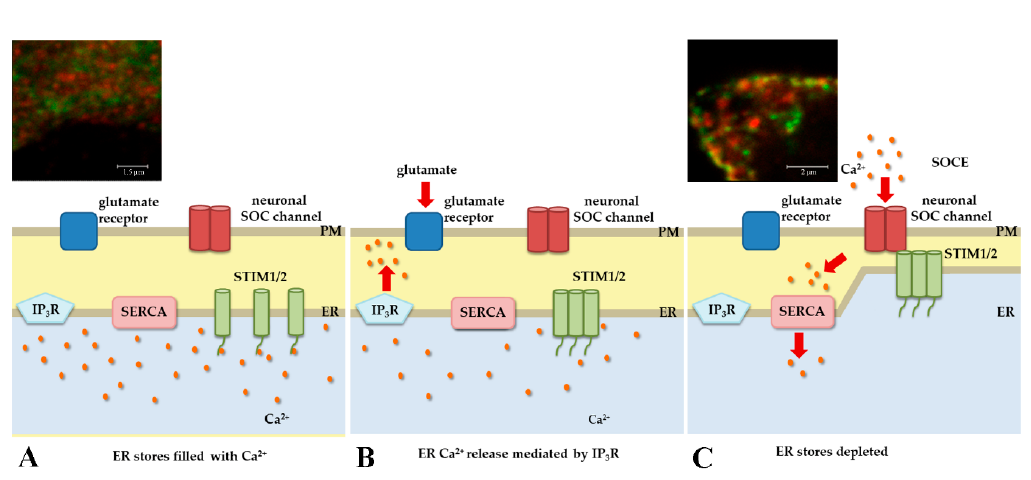
Figure 2. Model of coupling between STIM1 / 2 proteins and Orai channels during SOCE. ( A ) In the absence of external stimuli, STIM1 / 2 proteins are equally distributed throughout ER membrane and ER Ca 2 + concentration is high. ( B ) After glutamate activation, IP 3 R depletes ER Ca 2 + stores. Ca 2 + dissociates from STIM1 / 2 N-terminal domain which results in STIM1 / 2 oligomerization and translocation to the PM. ( C ) STIM1 / 2 binds to Orai1, thereby activating SOCE. Then, SERCA pump transports Ca 2 + from cytoplasm to ER to refill the stores with Ca 2 + . ( A , C ) The upper panels show confocal images of neurons co-expressing Orai1 (red) and YFP-STIM1 (green) before ( A ) and after store depletion by thapsigargin ( C ) where the proteins are redistributed equally and colocalized forming the complexes (yellow), respectively (modified from images in [41] with permission from Elsevier).